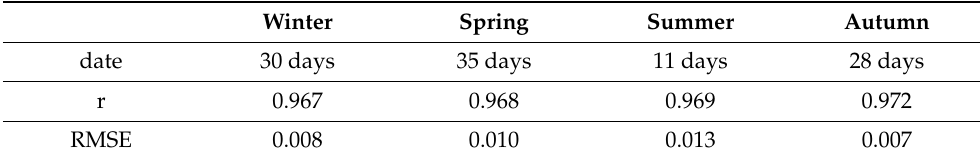
Table 3. Evaluation of inversion results for 4 seasons in